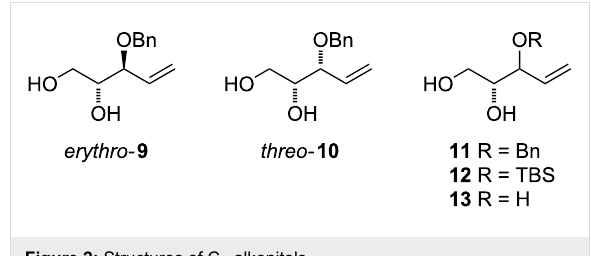
Figure 2: Structures of C 5